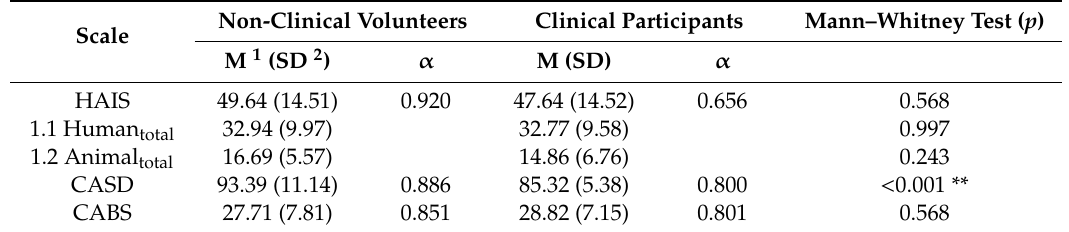
Table 2. Means, standard deviations, Cronbach’s alpha and between group di ff erences.